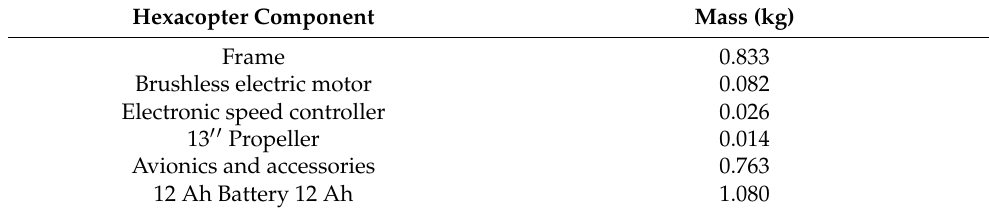
Table 1. Mass of the hexacopter components.